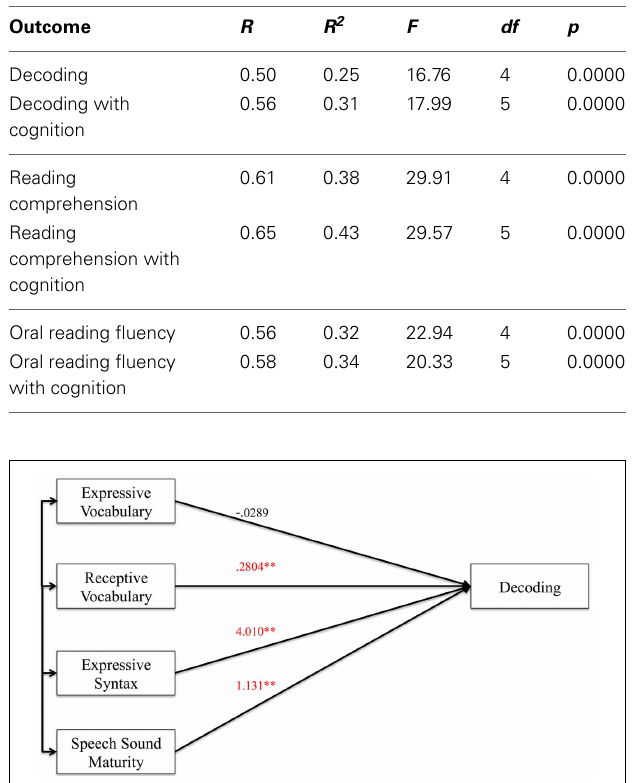
Table 5 | Model summaries for total (without mediator) and direct (with mediator) effects of early skills on the components of reading.